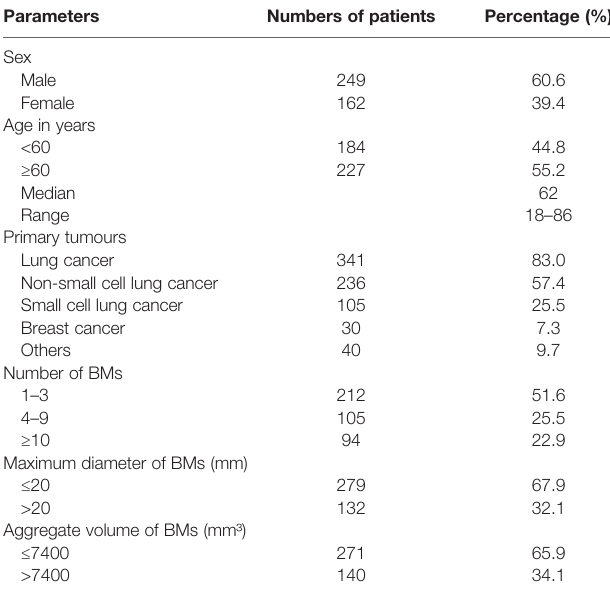
TABLE 1 | Patients characteristics (n = 411).